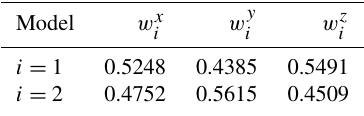
Table 1. Standard and perturbed parameter values for the Lorenz 63 system.